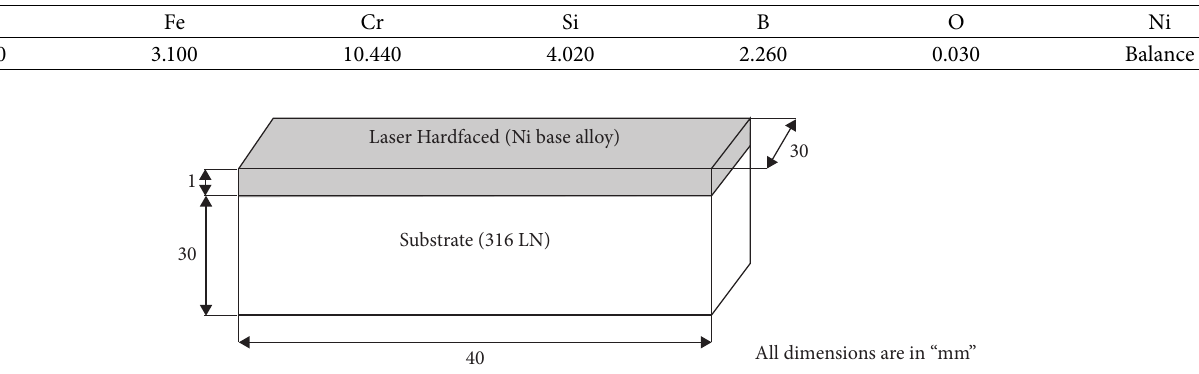
Table 2: Colmonoy 5 hardfaced power chemical composition in wt %.